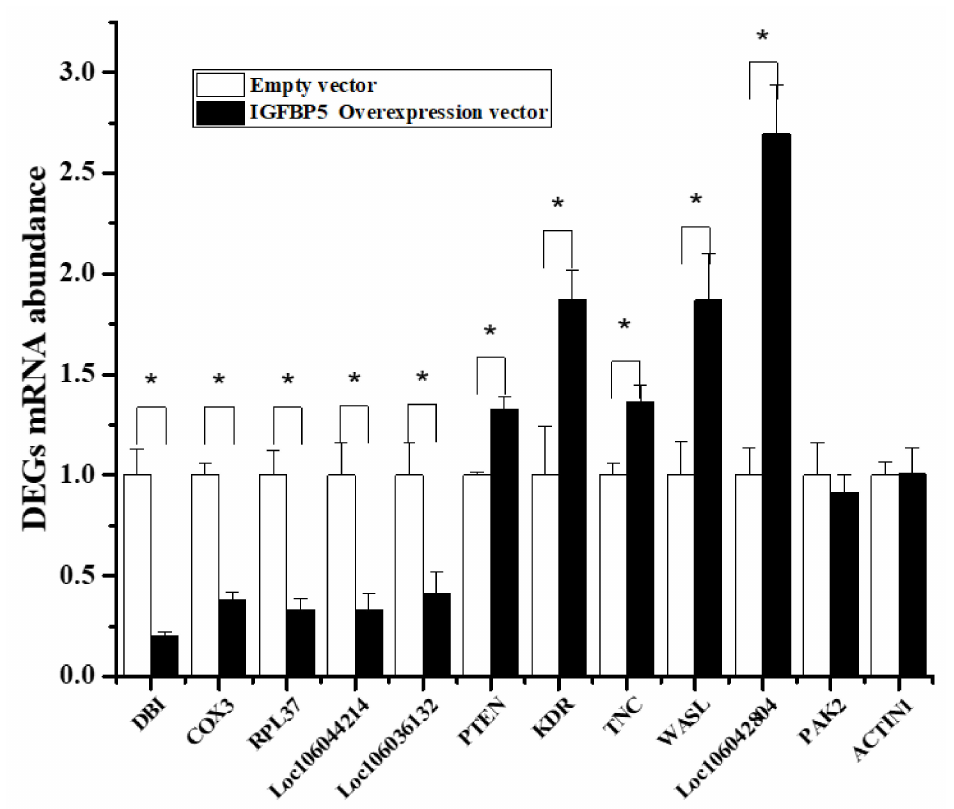
Figure 7. Quantitative PCR-based validation on the representative DEGs identified by transcriptome analysis. Note: The RNA samples for quantitative PCR analysis were isolated from goose primary hepatocytes transfected with IGFBP5 overexpression vector (black box) or empty vector (white box). Control denotes empty pcDNA3.1(+) vector. n = 4. All data are expressed as the mean ± SEM. * denotes p <